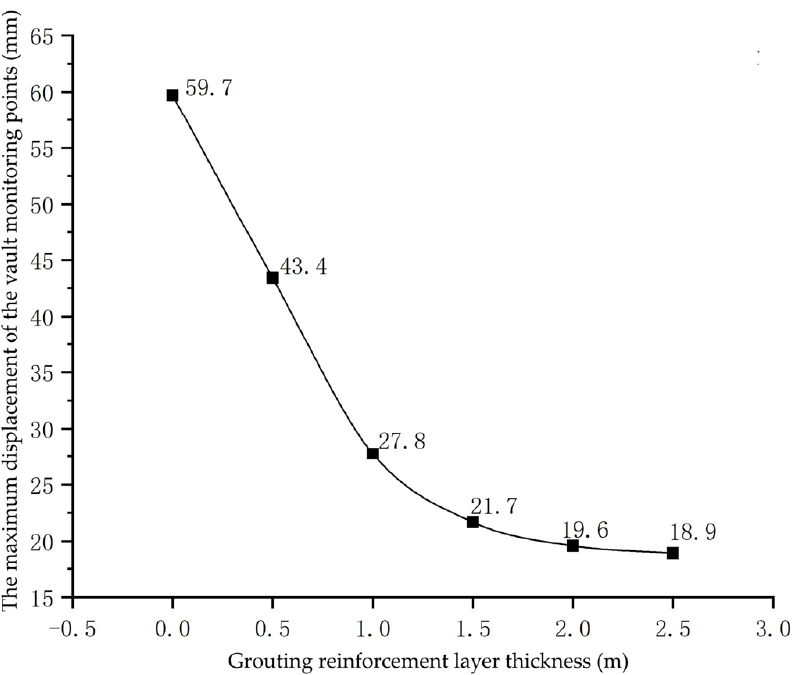
Figure 16. Relationship between the maximum displacement of the vault and grouting reinforcement layer thickness.